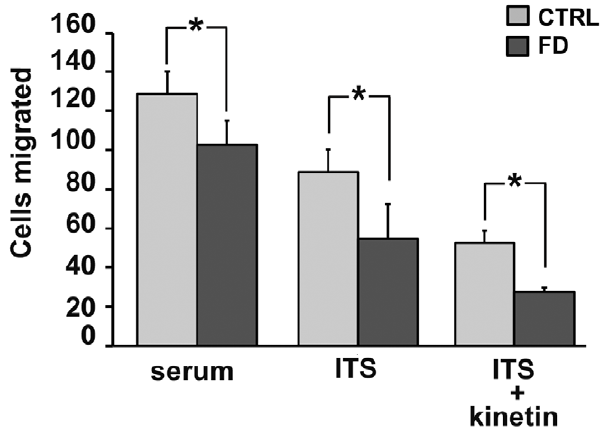
Figure 5. FD hOE-MSCs demonstrate reduced migration. Cell invasion in 3 different controls and 3 different FD hOE-MSCs was studied using Boyden chamber assay. Cells (3 6 10 4 ) were added to the upper chamber in serum medium, serum-free medium (ITS), or ITS supplemented with 100 m M kinetin. Cell invasion was mesured after 24 h. Results are shown as the average 6 SEM of the number of cells per microscopic field. (* P , 0.05).